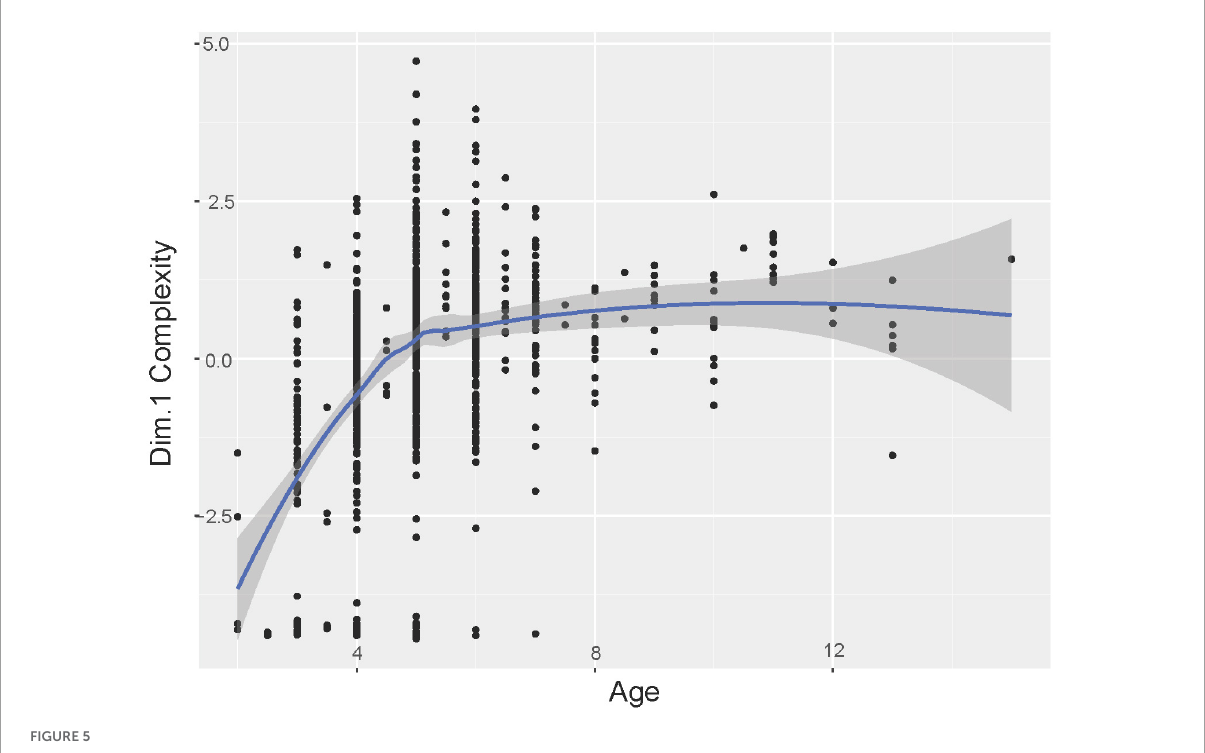
FIGURE5 Children’s drawing behavior for dimension 1 (i.e., complexity) according to age.